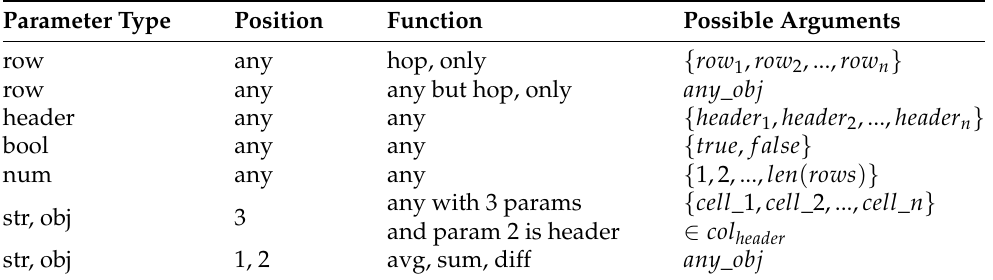
Table 4. Possible arguments for different parameter types, positions, and